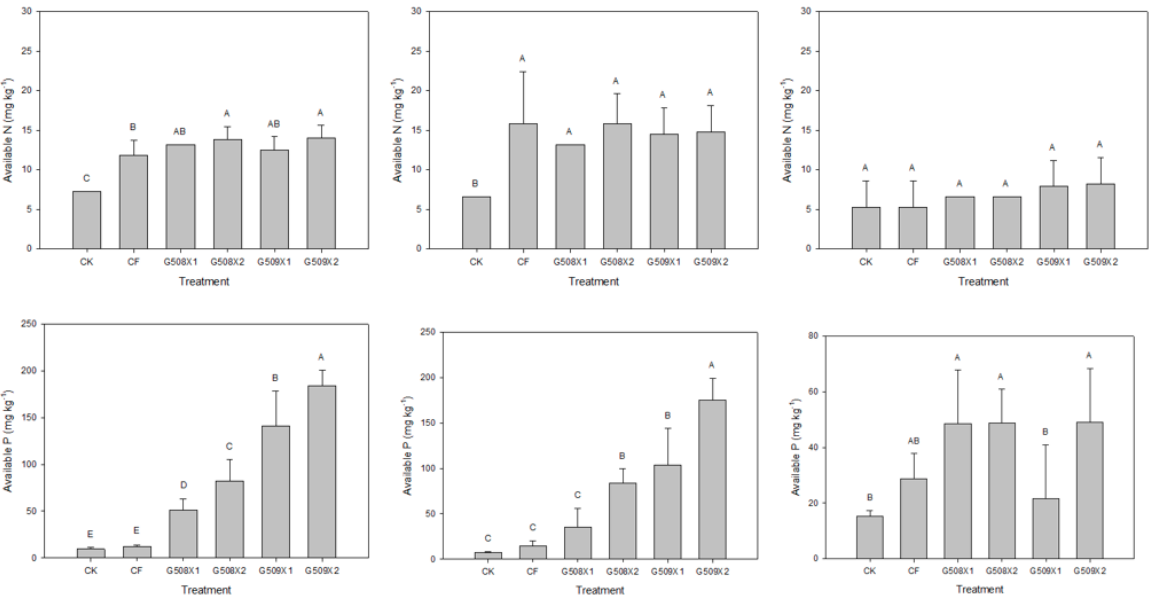
Figure 3. The contents of available N and available P of the soil after the field experiment under different treatments: cabbage ( left ), Chinese cabbage ( middle ), and water spinach ( right ). The different letters indicate the significance among the treatments obtained through one-way ANOVA analysis (Duncan test, p < 0.05, n = 4). The codes have the same meanings as those in Figure